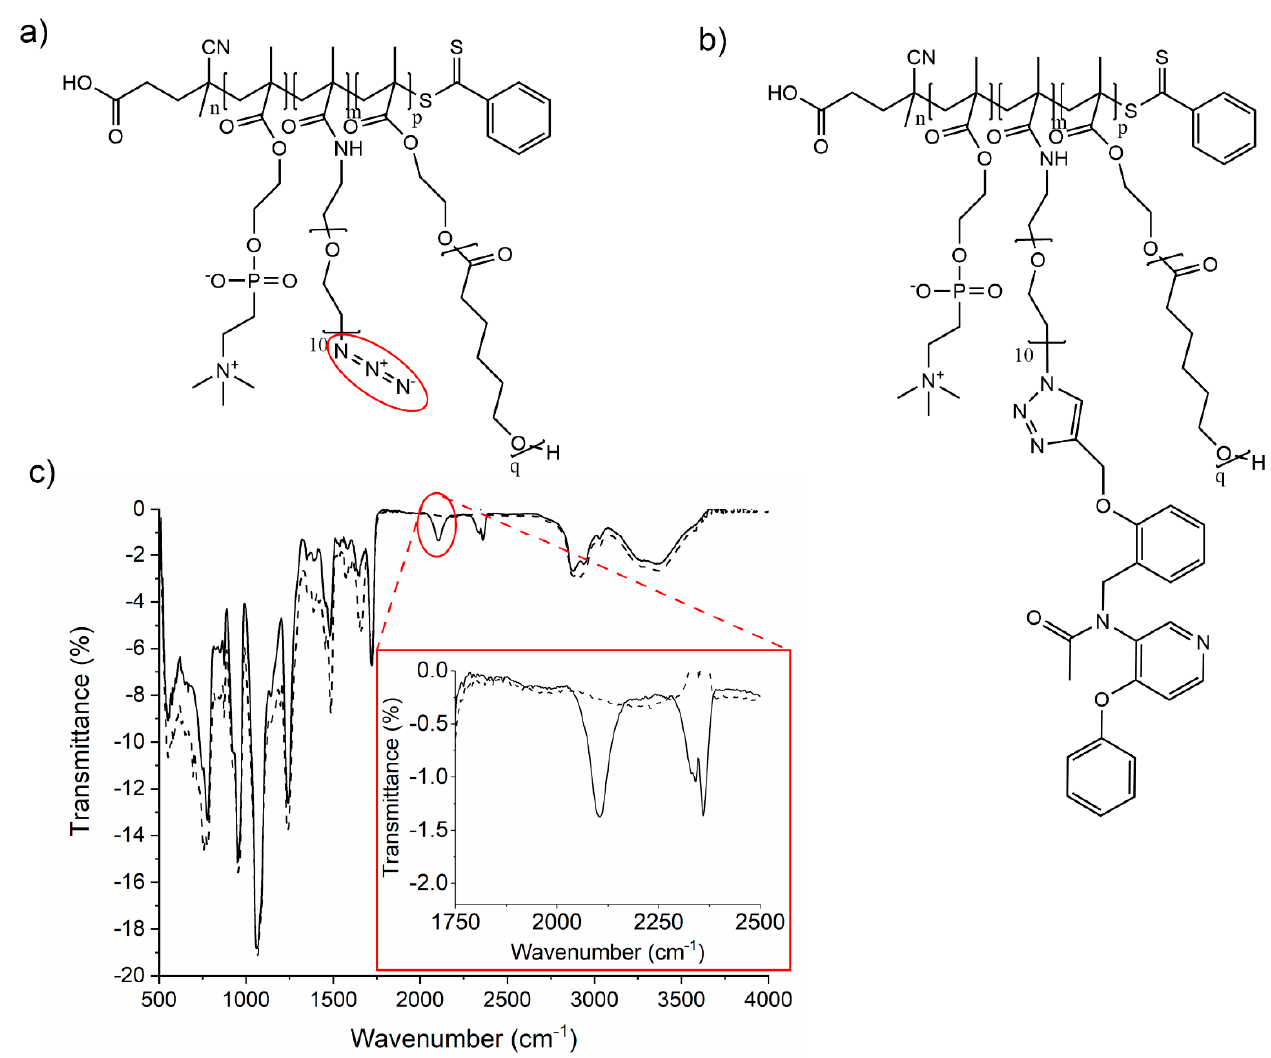
Figure 4. ( a ) Chemical structure of nMPC-mMePEGN 3 -pCLq, ( b ) Chemical structure of the functionalized polymer nMPC- mMePEGPBR-pCLq, ( c ) FT-IR spectra of the azide functionalized block copolymers 25MPC-6MePEGN 3 -30CL5 (solid line, entry 7 in Table 2) and of the product generated after the click reaction with PBR-alkyne, 25MPC-6MePEGPBR-30CL5 (dotted line, entry 3 in Table 2). The inset shows a magnification of the characteristic azide stretching band before (solid line) and after (dotted line) the conjugation with PBR-alkyne.